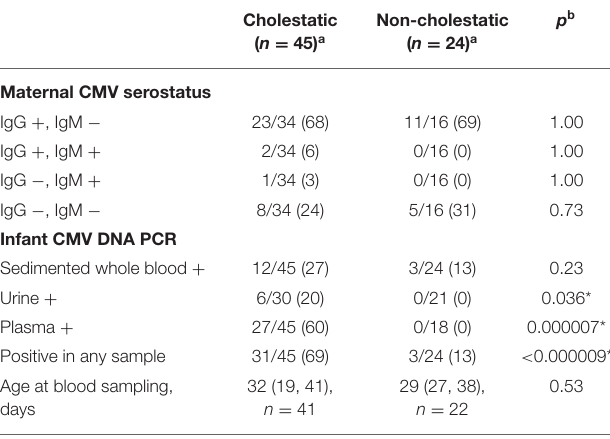
TABLE 2 | CMV status in cholestatic and non-cholestatic infants.